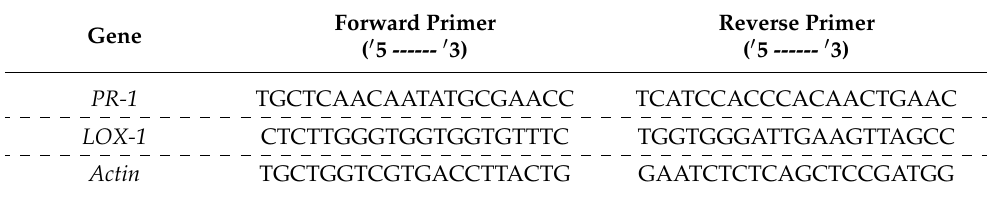
Table 1. Forward and reverse primers sequence for PR-1, LOX-1 and actin genes. Forward Gene